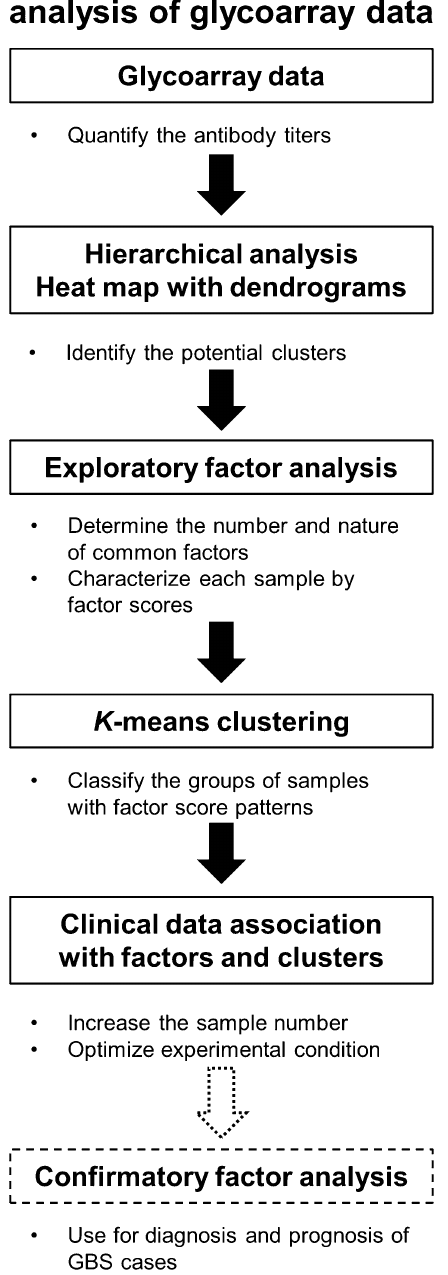
Figure 2. A workflow of factor analysis of glycoarray data from GBS patients. Using glycoarray data, we quantified the total 55 glycolipid antibody titers of 100 GBS and 30 healthy control serum samples. As a hierarchical analysis, we drew a heat map with dendrograms based on similarities of anti-glycolipid antibody titer patterns among samples, identifying the potential clustering of a set of anti-glycolipid antibodies. Using exploratory factor analysis, we identified the number and nature of common latent factors, each of which was associated with a distinct set of anti-glycolipid antibodies, and characterized individual samples by the factor scores of the common factors. Using k -means clustering based on the factor scores of individual samples, we classified GBS samples into several clusters with distinct factor score patterns. We associated clinical data with the factors and the patient clusters. In the future, by increasing the number of samples and optimizing the glycoarray condition, confirmatory factor analysis will be applicable for the diagnostic or prognostic purpose of GBS